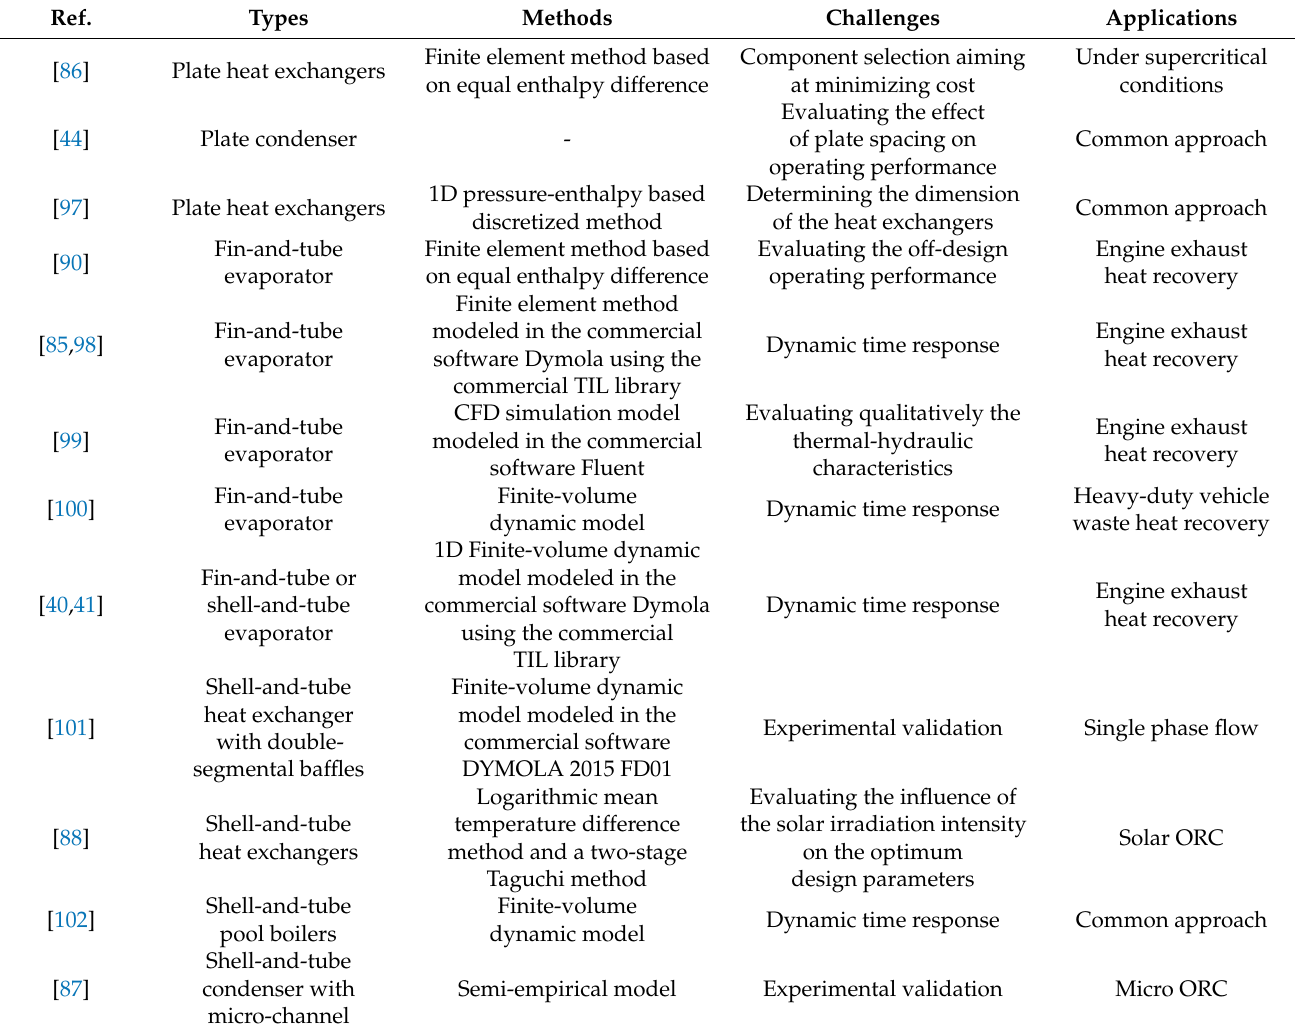
Table 3. Some design investigations conducted on different types of the heat exchangers.